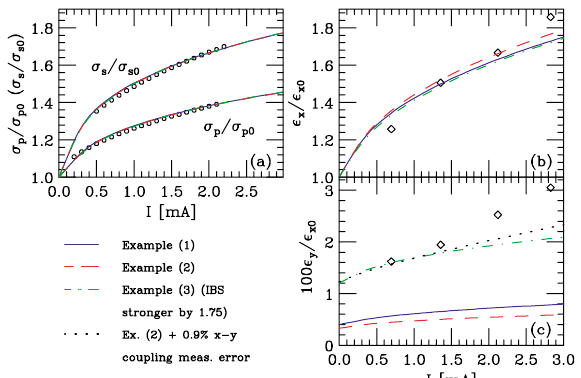
FIG. 6. (Color) ATF measurement data (symbols) and IBS the- ory fits (the curves). The symbols in (a) give the smooth curve fits to the measured data of Fig.